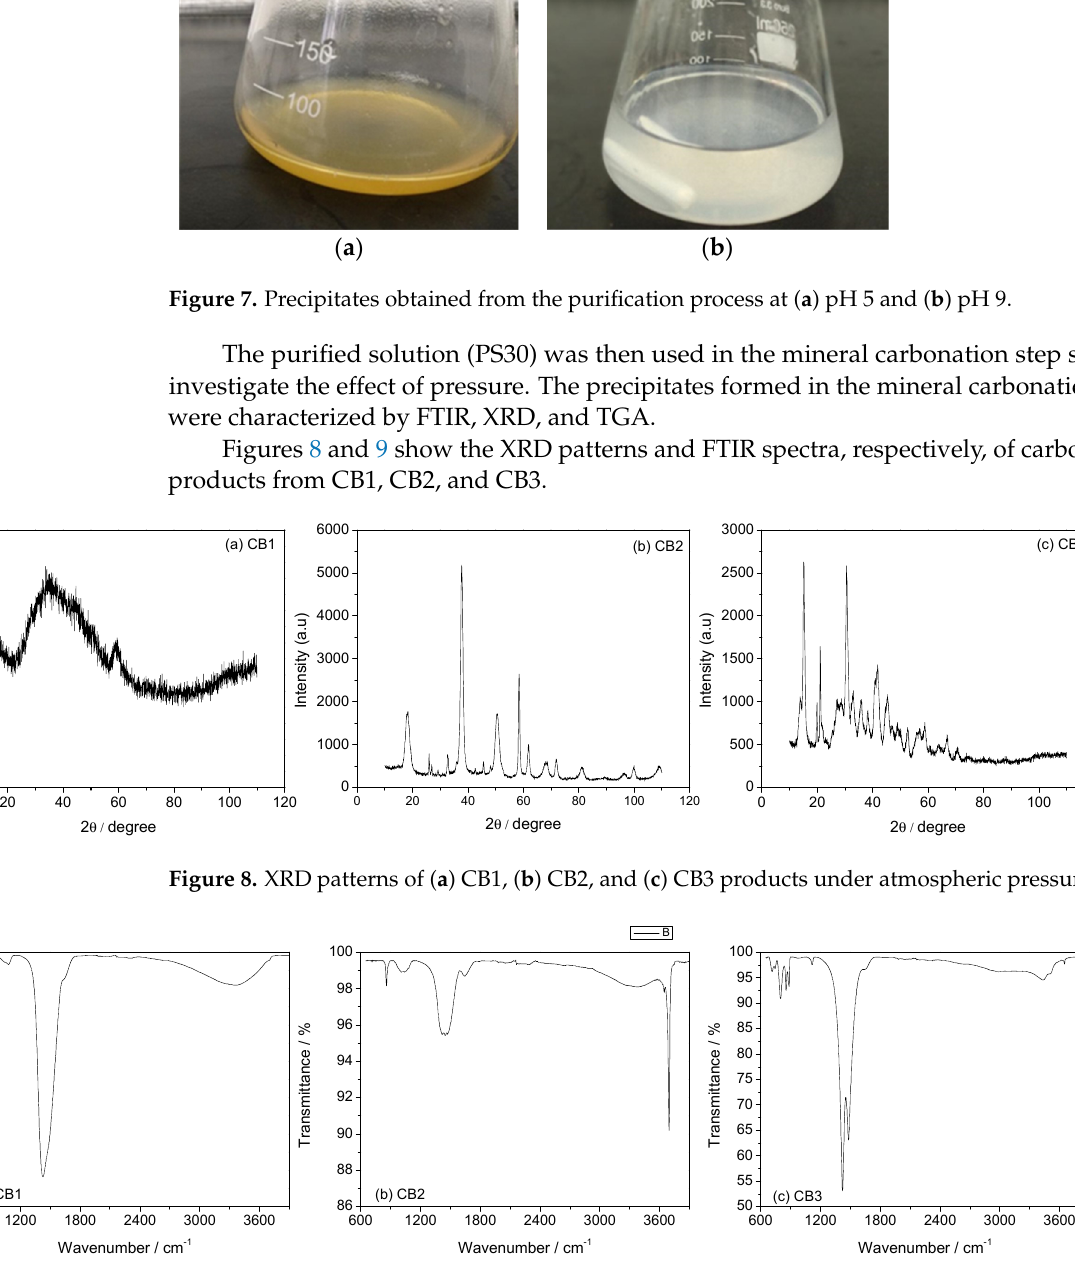
Figure 7. Precipitates obtained from the purification process at ( a ) pH 5 and ( b ) pH 9. The purified solution (PS30) was then used in the mineral carbonation step so as to were characterized by FTIR, XRD, and TGA.